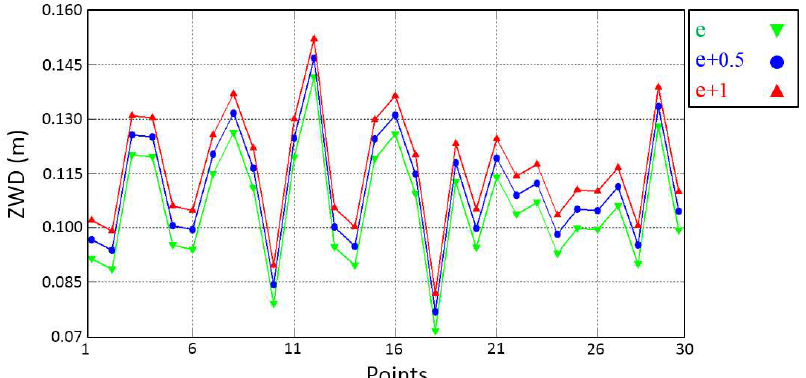
Figure 1. An example of the sensitivity analysis of the zenith wet delay (ZWD) to changes in water vapor pressure e [hPa]. The green line shows the computed ZWD using the actual e. The blue and red lines indicate the computed ZWD using changed e in all layers.